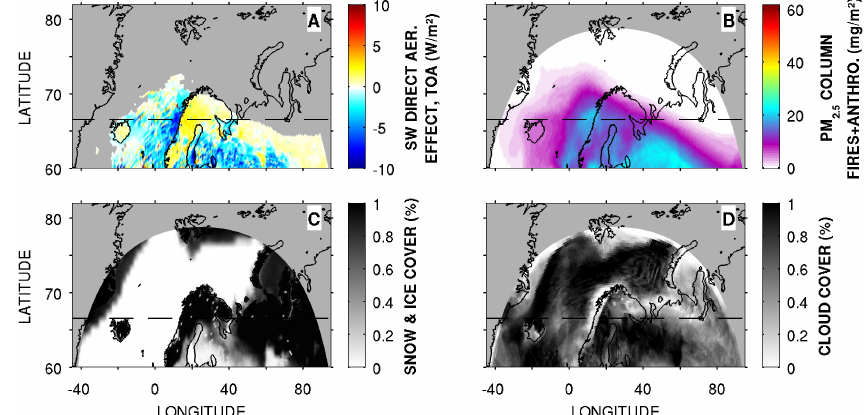
Figure 13. Model averages over the period from 00:00UTC 8 April 2008 to 00:00UTC 12 April 2008 of the (a) aerosol DSRE, at the TOA, in regions significantly affected by in-domain anthropogenic and fire emissions, (b) PM 2 . 5 column sensitivity to anthropogenic and biomass burning emissions, and (c) fractional snow and sea ice cover, (d) fractional cloud cover. In panel (a) , regions not significantly affected by in-domain emissions are masked in gray. In panels (b–d) , regions outside of the WRF-Chem domain are masked in gray. The Arctic Circle is indicated by a dashed line.